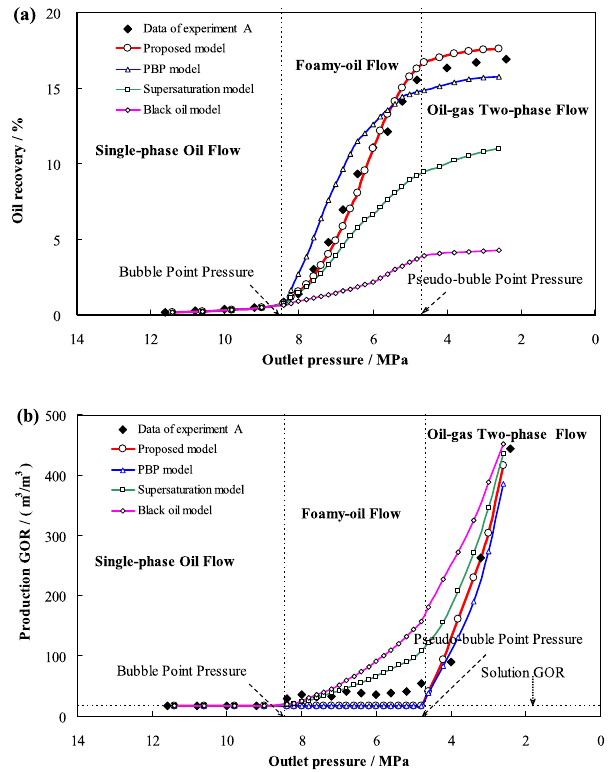
Figure 4. The simulated results by the four models in comparison with the experimental data for experiment A. ( a ) oil recovery with respect to outlet pressure. ( b ) Production GOR with respect to outlet